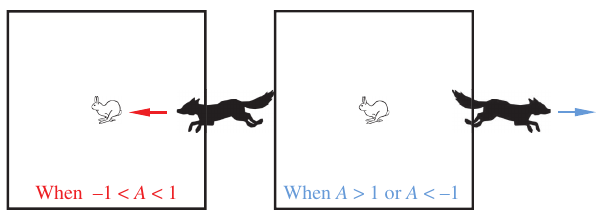
Figure 1: Exploitation and Exploration in